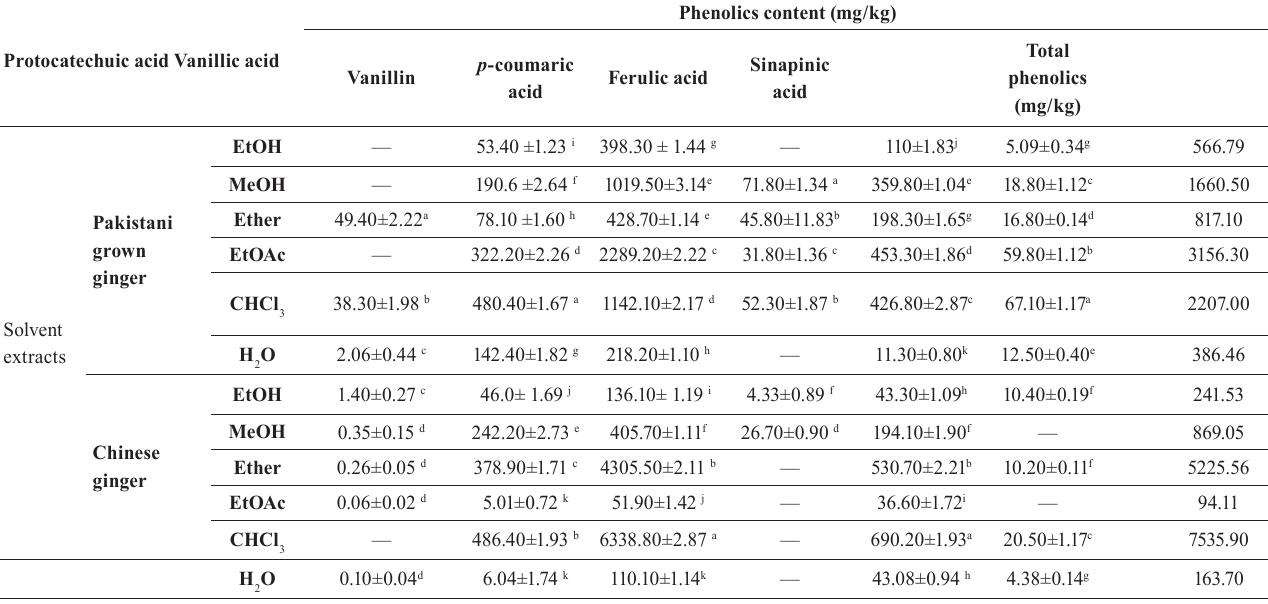
TABLE I - P rofiling of individual phenolics in extracts from Pakistani and Chinese grown ginge